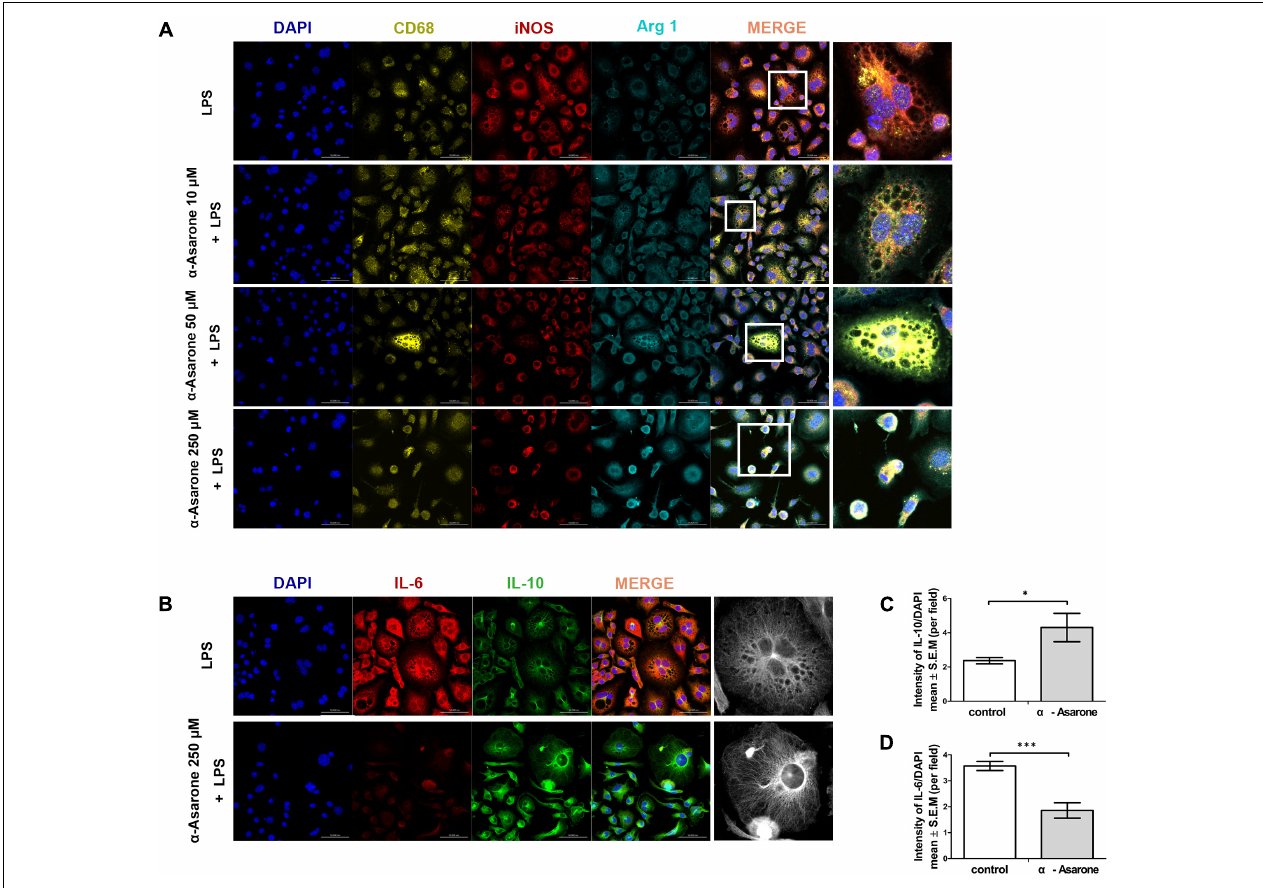
FIGURE 3 | α -asarone promotes M2 macrophage polarization in vitro . (A) Immunolabeling for CD68 (yellow, macrophage marker), inducible nitric oxide synthase (iNOS; red, M1 marker), and Arginase 1(Arg 1; turquoise, M2 marker), DAPI (4 (cid:48) ,6-diamidino-2-phenylindole) is used for nuclear counterstaining. Scale bars, 50 µ m. (B) Immunolabeling for interleukin-6 (IL-6, red) and interleukin-10 (IL-10, green). Scale bars, 50 µ m. (C) Quantitative analysis of immunohistochemistry for IL-6. ∗ P < 0.05, one-tailed Student’s t -test ( n = 5). (D) Quantitative analysis of immunohistochemistry for IL-10. ∗∗∗ P < 0.001, one-tailed Student’s t -test ( n =